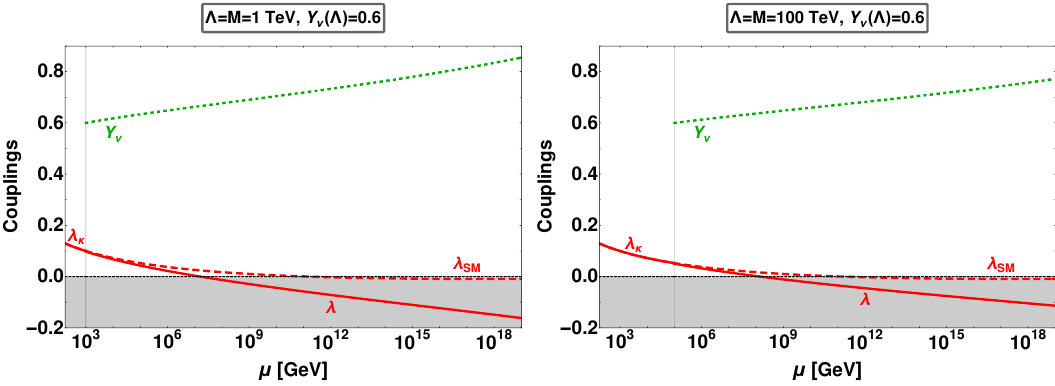
Figure 3 . Evolution of the Higgs quartic self-coupling λ (solid-red) and Yukawa coupling Y ν (dotted-green) within the minimal (3,1,1) inverse seesaw scheme. λ κ is the quartic coupling in the effective theory with the Weinberg operator. For comparison, we also plot the running of λ SM , the SM quartic coupling, indicated by the dashed-red